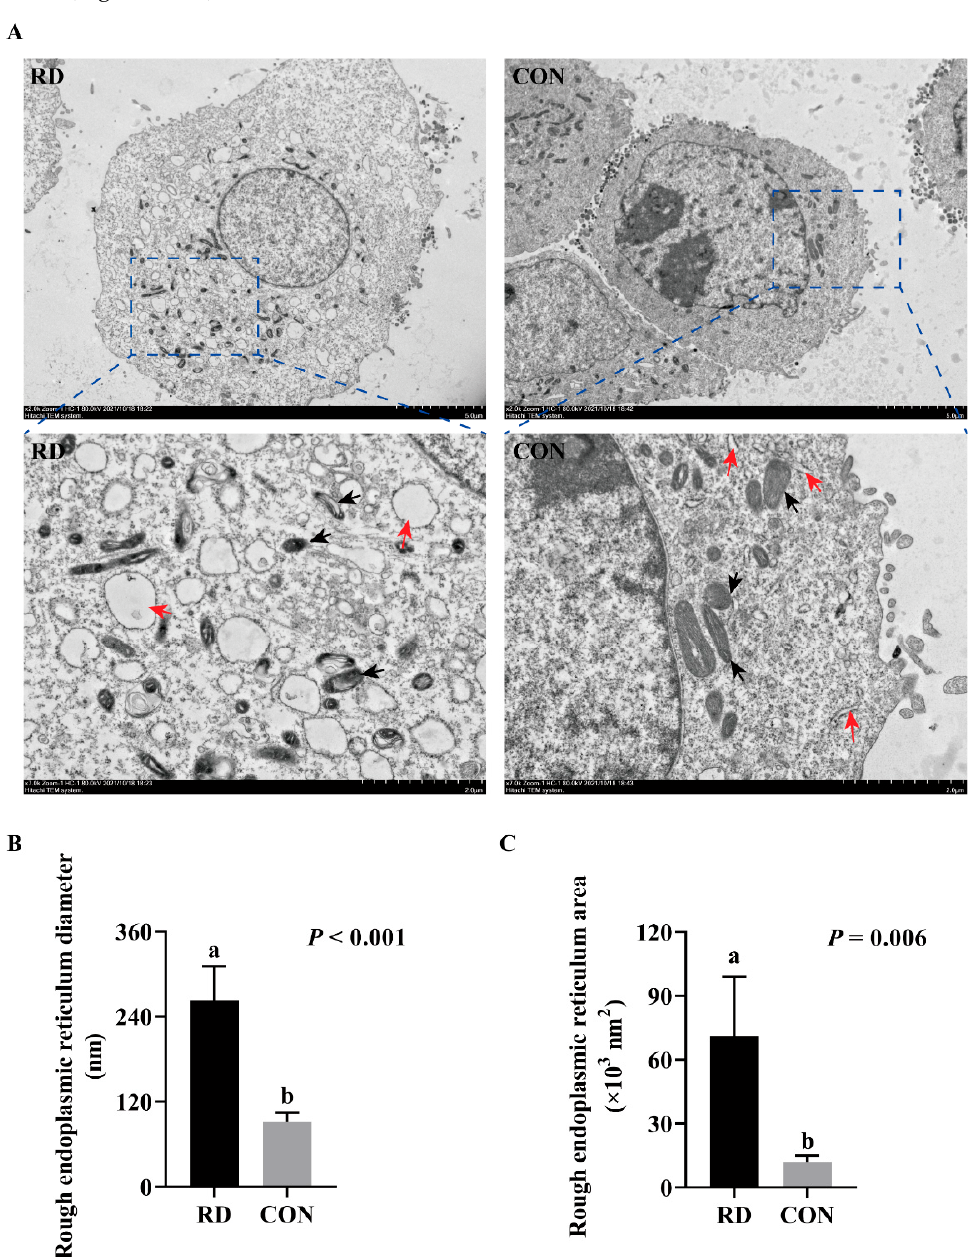
Figure 3. RD induces the swelling of the endoplasmic reticulum (ER). ( A ) The cellular ultramicro- scopic structures observed by transmission electron microscopy (TEM); black arrowheads point to ER, and red arrowheads point to mitochondria. Effect of RD on the diameter ( B ) and area ( C ) of rough ER. Values are expressed as means ± SD. Different letters indicate significant differences ( p < 0.05). Each treatment is performed in four replicates ( n = 4).